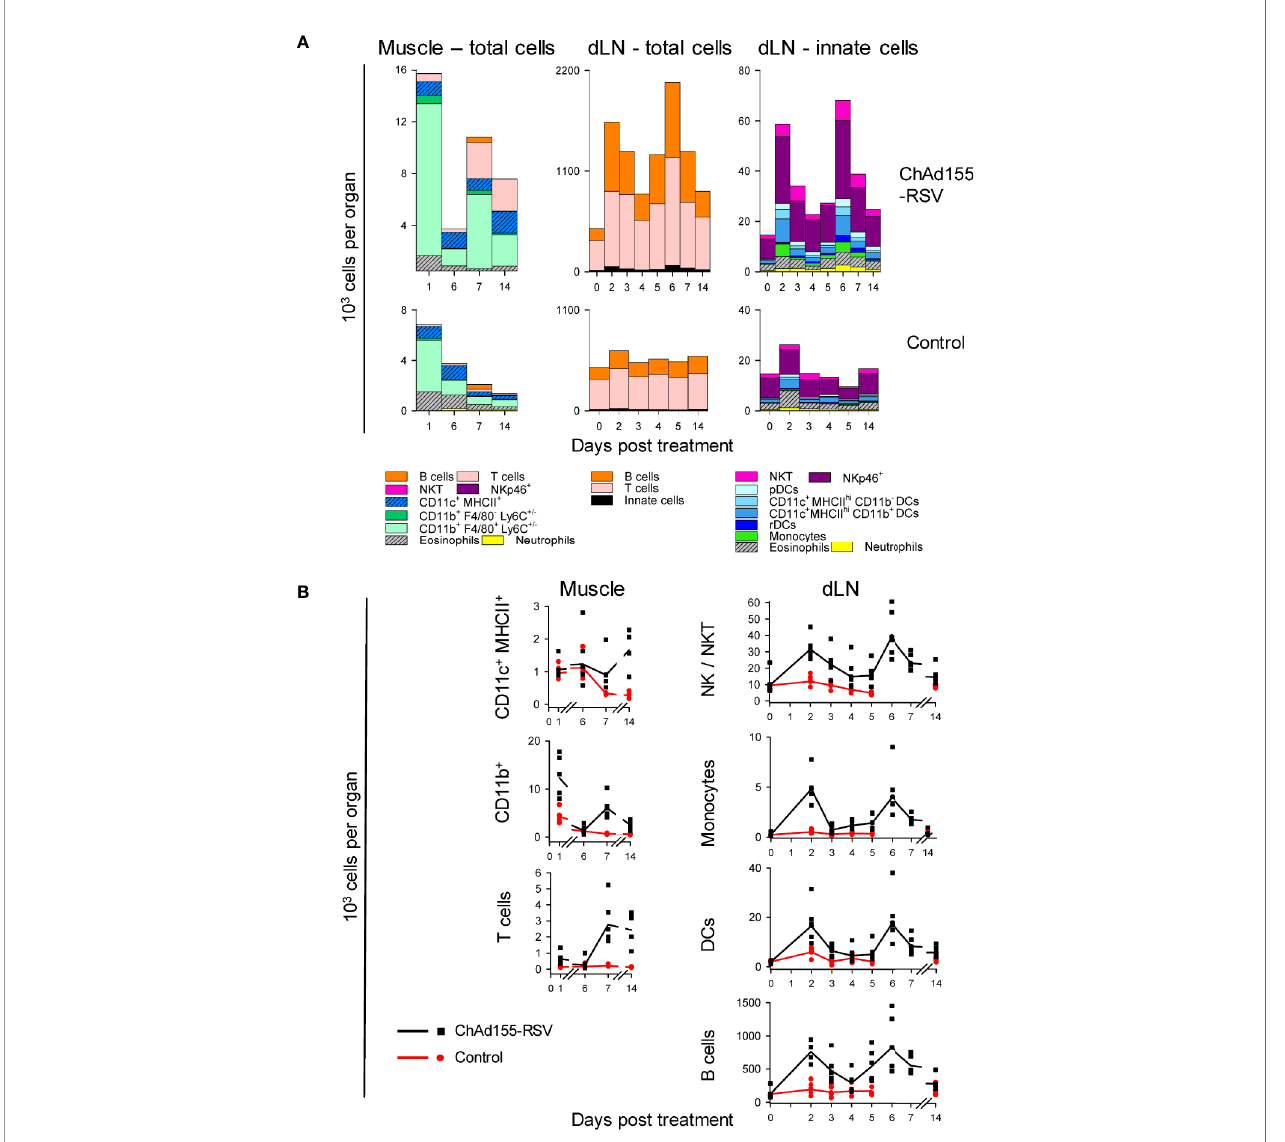
FIGURE 3 | Kinetics of immune cell in fi ltration in mice. The composition of immune cell in fi ltrates in muscles and draining lymph nodes (dLNs) collected from mice (n = 5/group/time point) immunized with ChAd155 RSV (10 8 vp) or phosphate-buffered saline ( “ Control ” ) are shown. Injections were performed bilaterally as two half doses (10 µl each) in both gastrocnemius muscles at Day 0. Injected muscles were collected after immunization (Days 1, 6, 7, and 14); dLNs were collected both before (0 h) and after immunization (Days 2 – 7 and 14; note the discontinuity in time points on x-axes). All cells recovered from muscles and 10 6 cells of the total recovered dLN cells were stained and analyzed by fl ow cytometry; values represent both the cell count per tissue and the number of total events detected by FACS (i.e., CD45 + living muscle cells and total living dLN cells). Geometric means of number of cells per tissue are presented as cumulative bars (A) or lines (B) . Each symbol in (B) represents one animal. Graphs represent data from single experiments performed for each